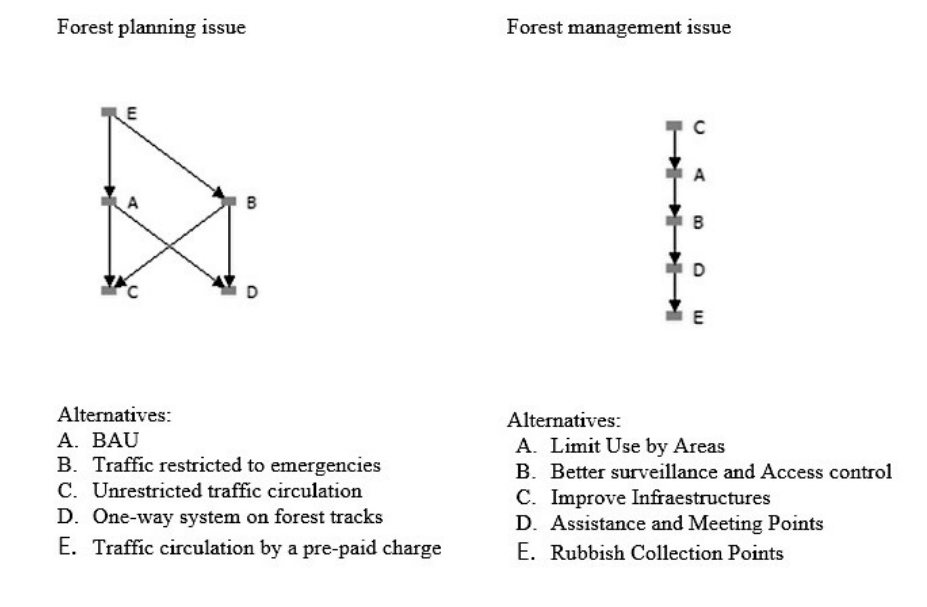
Figure 4. Ranking of planning and management